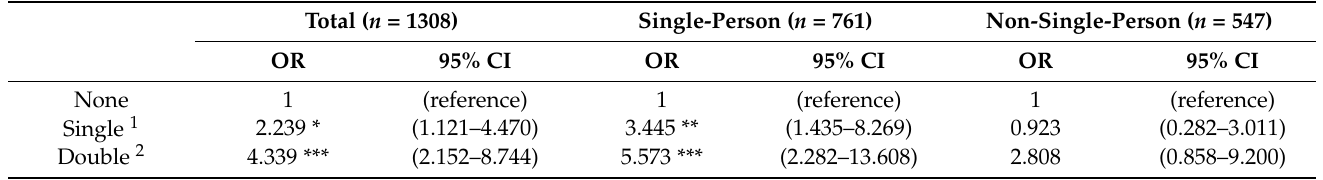
Table 3. Association between the breadth of housing problems and depressive